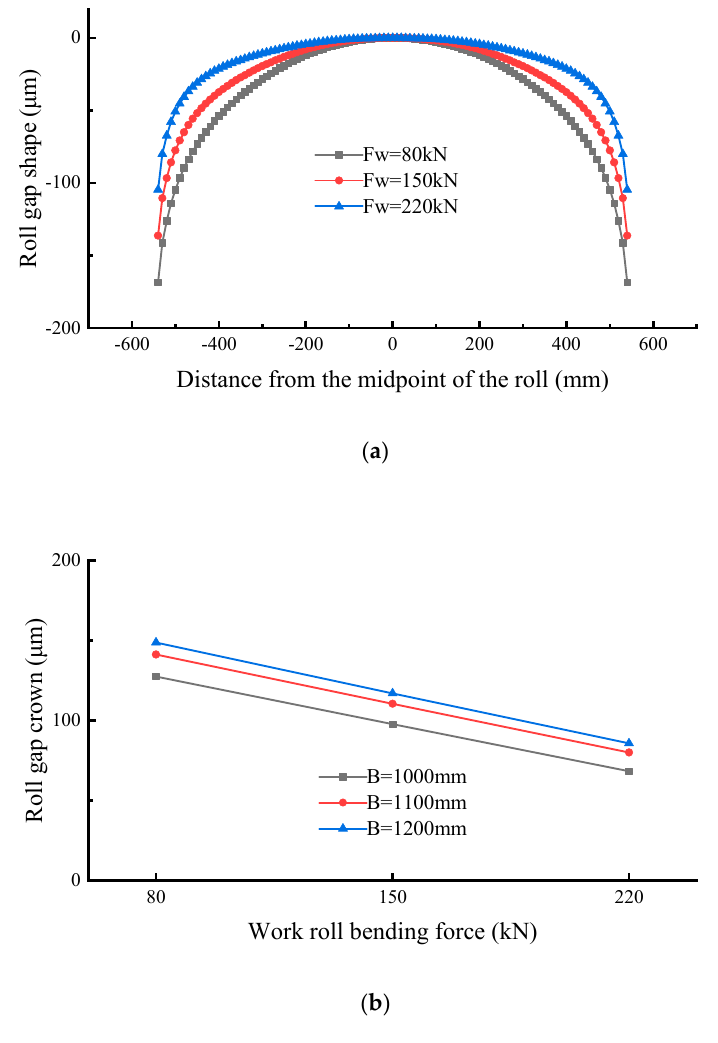
Figure 8. E ff ect of work roll bending force on roll gap shape. ( a ) Roll gap shape under di ff erent Figure 8. Effect of work roll bending force on roll gap shape. ( a ) Roll gap shape under different intermediate roll bending forces, ( b ) e ff ect of intermediate roll bending force on roll gap intermediate roll bending forces, ( b ) effect of intermediate roll bending force on roll gap crown.